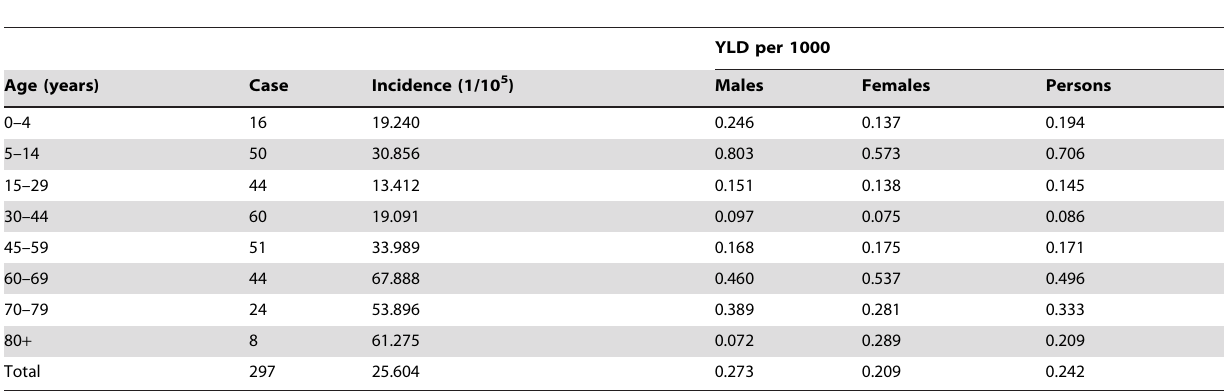
Table 3. The epidemiological burden of malaria caused by waterlogging alone during exposure effect-period for waterlogging.